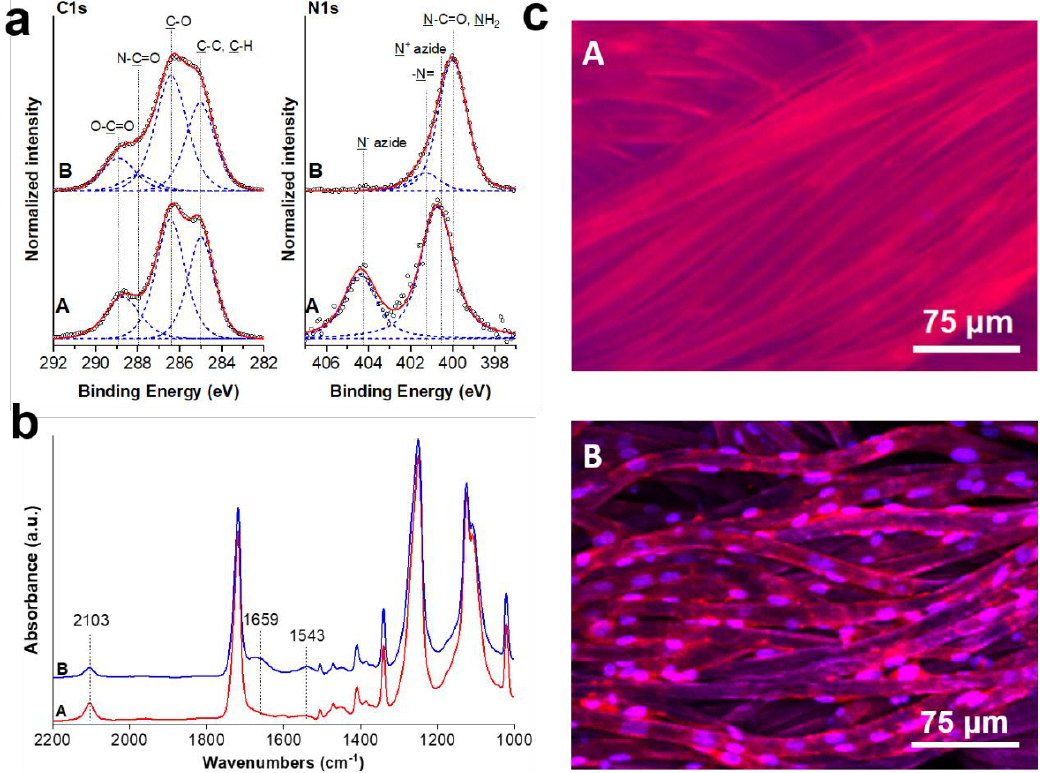
Figure 7. XPS ( a ) and GAATR-FTIR ( b ) characterization of PET conduits modified with antifouling hierarchical poly(MeOEGMA- block -GMA-N 3 ) polymer brushes ( A ) and their biofunctional counterparts with 1.2 × 10 3 nmol / cm 2 RGD peptide ( B ). HUVEC cell adhesion ( c ) on the respectively modified PET conduits. Actin filaments (red) and cell nuclei (blue) were stained by Phalloidin–Atto 594 and Hoechst 33342, respectively.